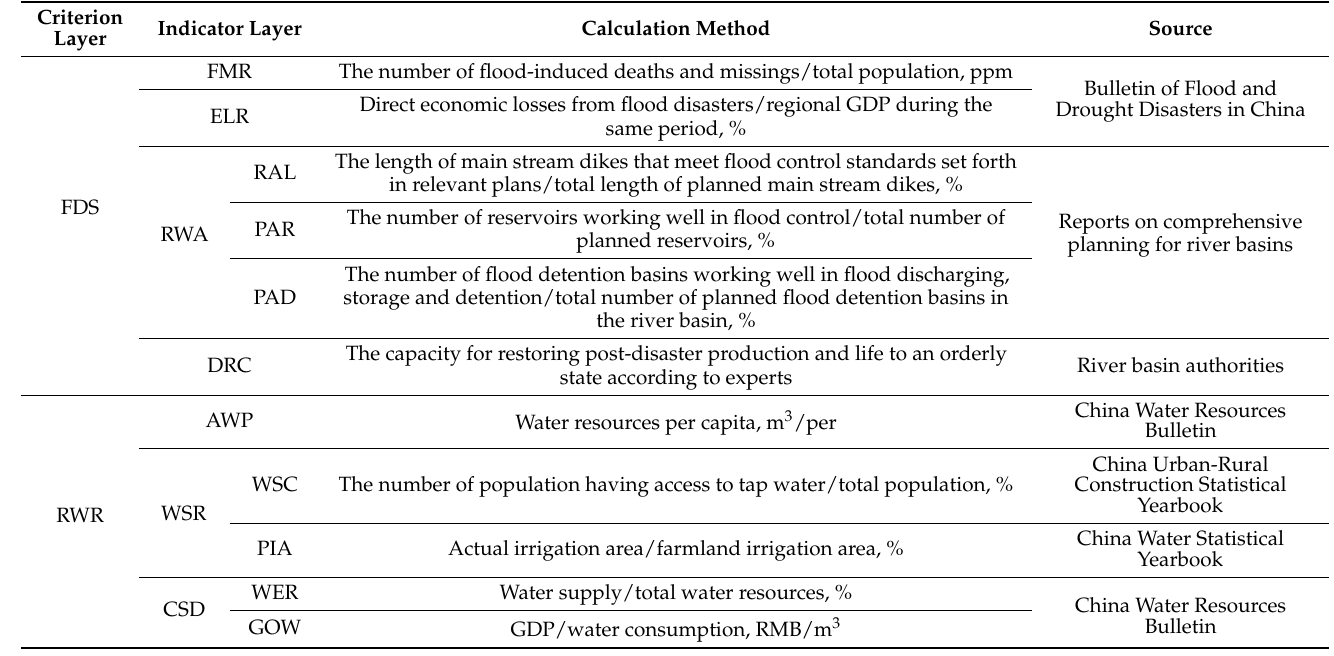
Table 7. Indicator calculation methods and sources of